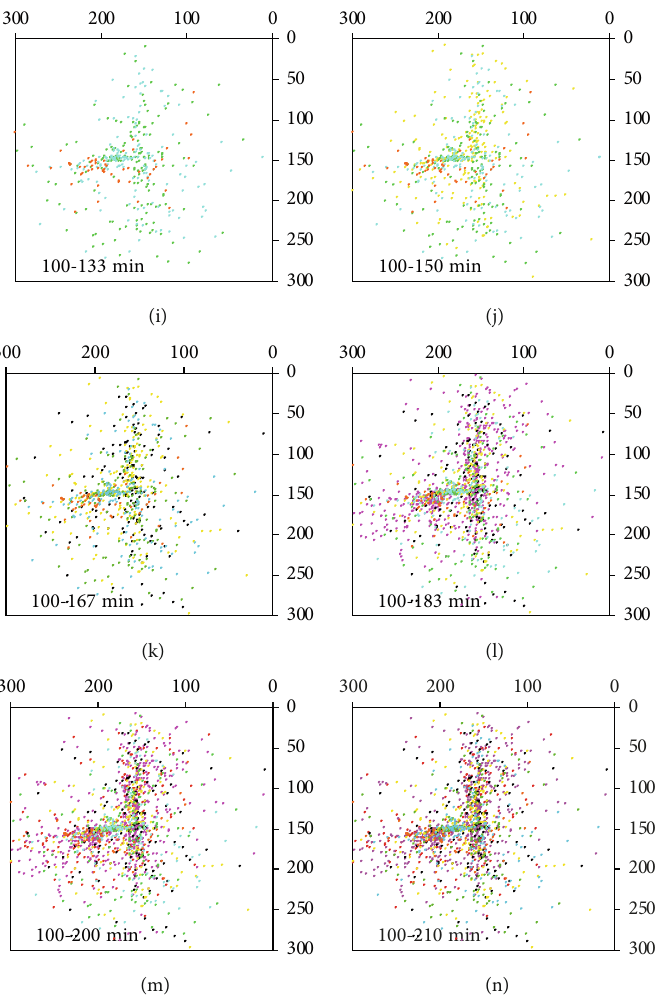
Figure 9: AE location map at di ff erent stages: (a) macroscopic failure of the sample; (b) AE location after failure; (c) AE location at 0-18min in the thermal cracking stage; (d) AE location at 0-33min in the thermal cracking stage; (e) AE location at 0-67 min in the thermal cracking stage; (f) AE location at 0-100 min in the thermal cracking stage; (g) AE location at 100-110 min in the fracture initiation stage; (h) AE location at 100-117 min in the fracture propagation stage; (i) AE location at 100-133 min in the fracture propagation stage; (j) AE location at 100-150min in the fracture propagation stage; (k) AE location at 100-167 min in the fracture propagation stage; (l) AE location at 100- 183min in the fracture propagation stage; (m) AE location at 100-200min in the fracture propagation stage; (n) AE location at 100- 210min in the fracture propagation